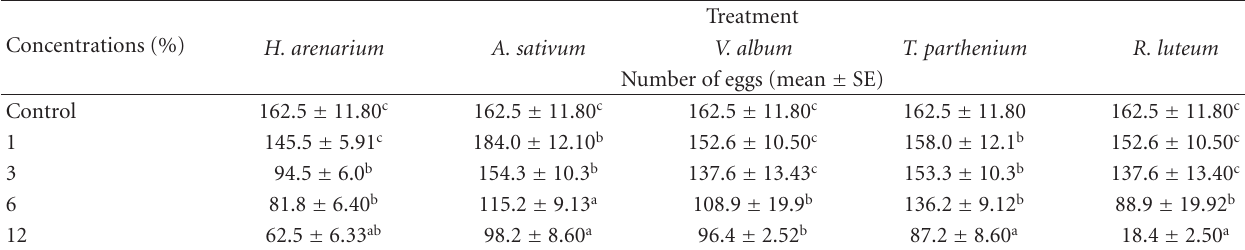
Table 2: E ff ect of extracts from obteined di ff erent five plants on egg laying capacity of T. urticae